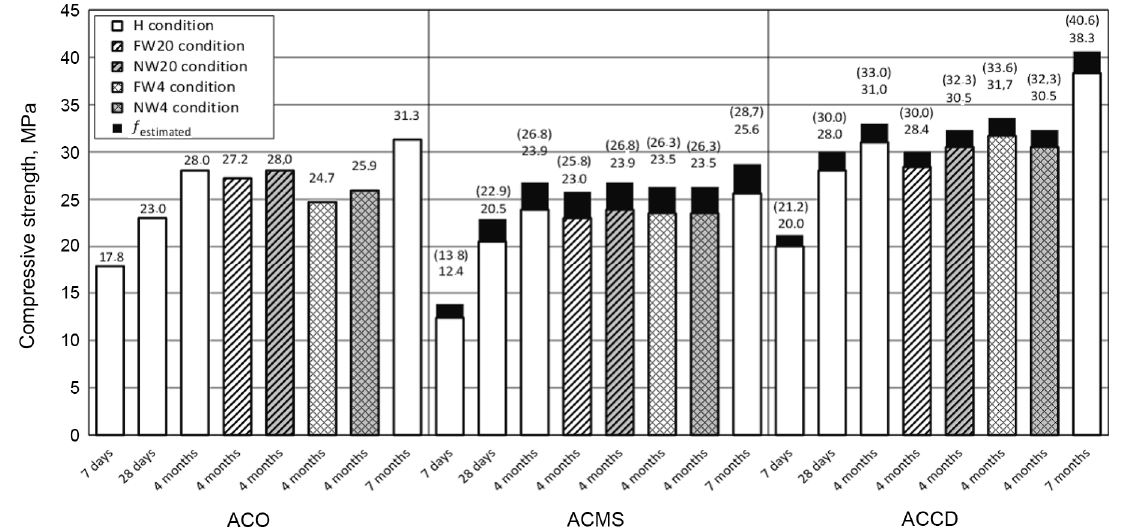
Fig. 6. The variation of actual and estimated strength (see formula 1) of ACP samples stored in various